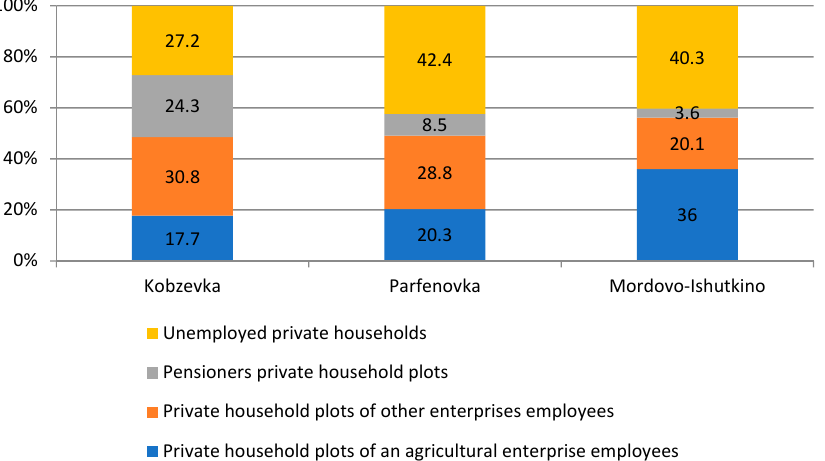
Figure 4. Comparison of private household plots by livestock availability in 2014–2018.